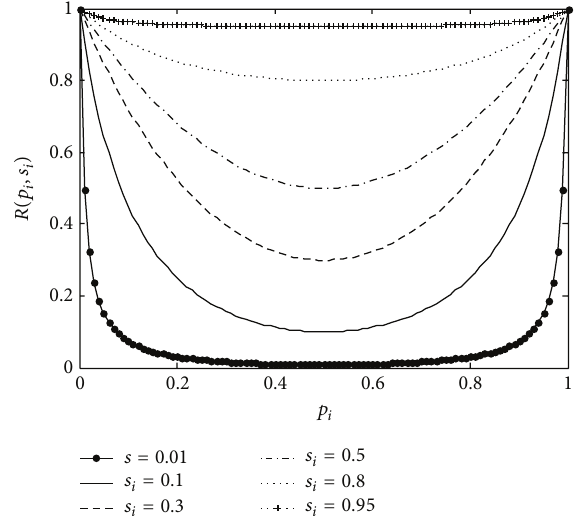
Figure 1: Reconstruction